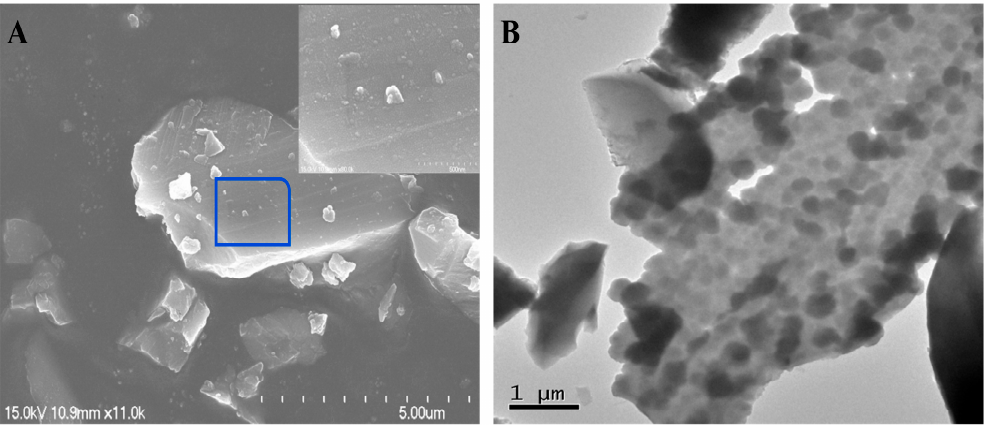
Figure 2. SEM ( A ) and TEM ( B ) images of MoS 2 /TiSi 2 -3.